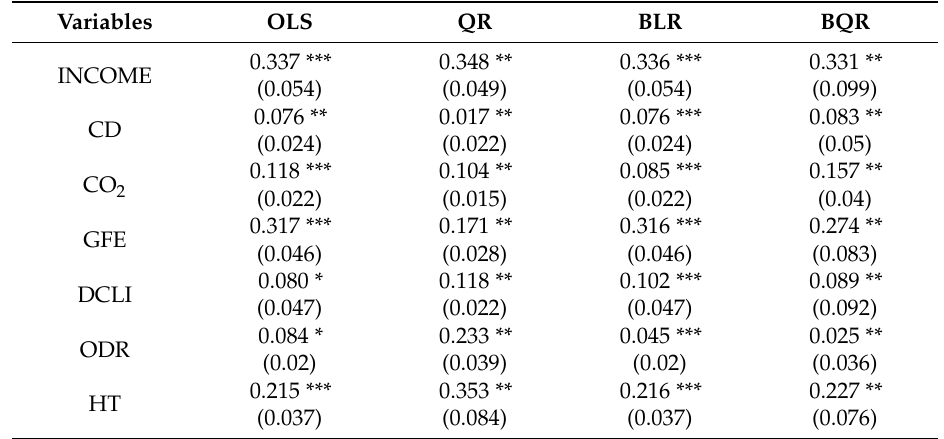
Table 6. Estimation results of Bayesian quantile regression (BQR) and traditional empirical methods (tau = 0.5 / mean).